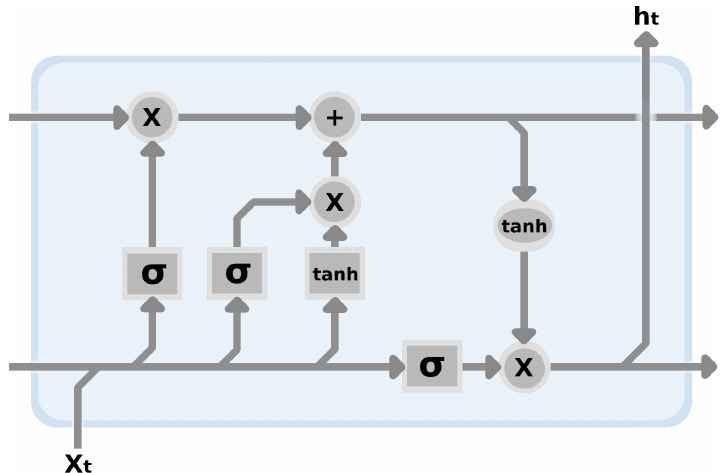
Figure 3. The LSTM (long short term memory) cell. Variables x t and h t are input and output, respectively, at time t . Squares with “ σ ” or “tanh” represent layers, whereas ovals with “X”, “+”, or “tanh” represent pointwise